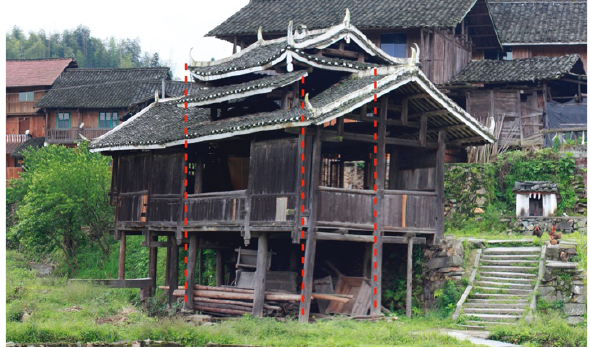
Figure 9 . Overall tilt of a typical Tai-liang Drum Tower